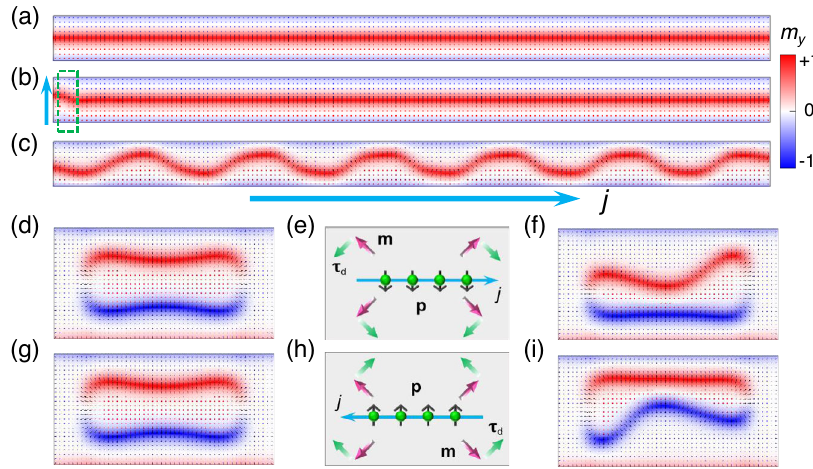
Fig. 2 Current-induced oscillation of a domain wall and an elongated skyrmion. Snapshots of the magnetization of a domain wall at a equilibrium, b initialization and c oscillation. The color bar represents the y component of the magnetization m y . The skyrmion oscillation driven by the spin current with the polarization d – f p ¼ (cid:2) ^ y and g – i p ¼ þ ^ y . Here, d and g represent the initial states, e and h are the schematic diagram of the local magnetization m (denoted by the pink arrows) and the damping-like torque τ d (denoted by the green arrows) induced by a spin-polarized current j fl owing along the blue arrow, ( f ) and ( i ) depict the snapshot of the magnetization at a selected time during the